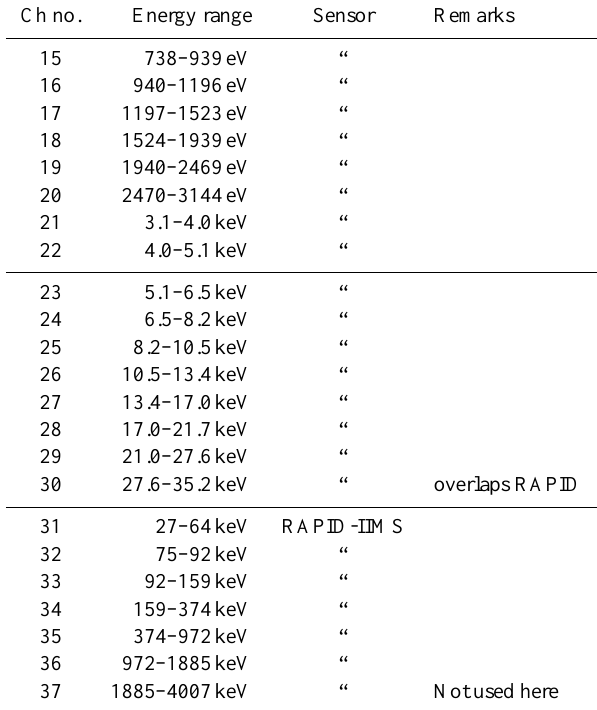
Table 1. Assignment of energy channels for the CIS-CODIF and RAPID instruments. The highest energies of CIS-CODIF overlaps with the lower energy range of RAPID. Ch